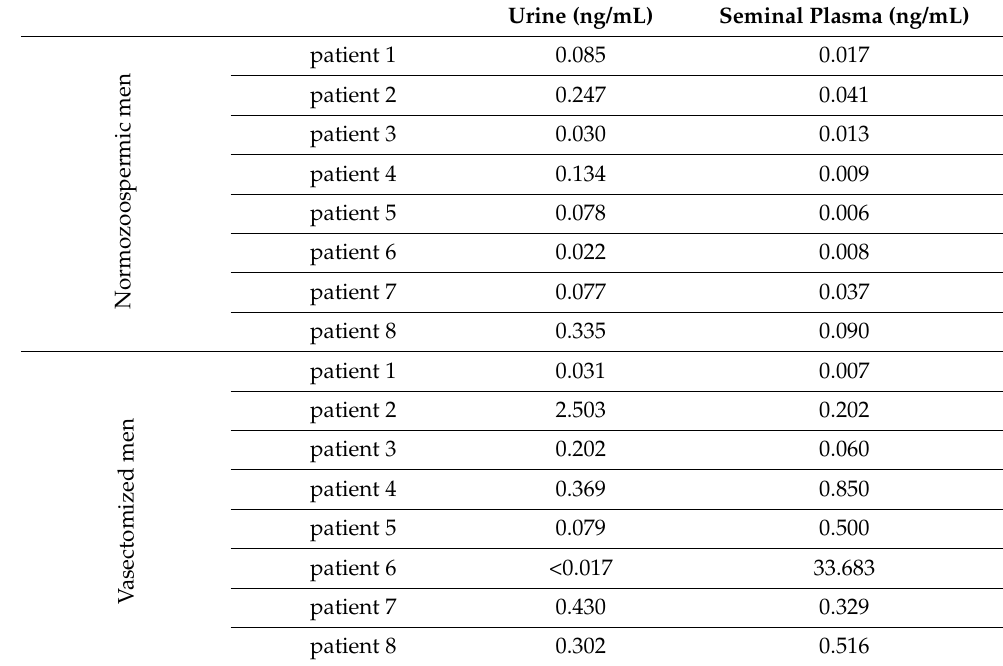
Table 3. Detection of bisphenol A (BPA) in all the observed patients in urine and in seminal plasma.